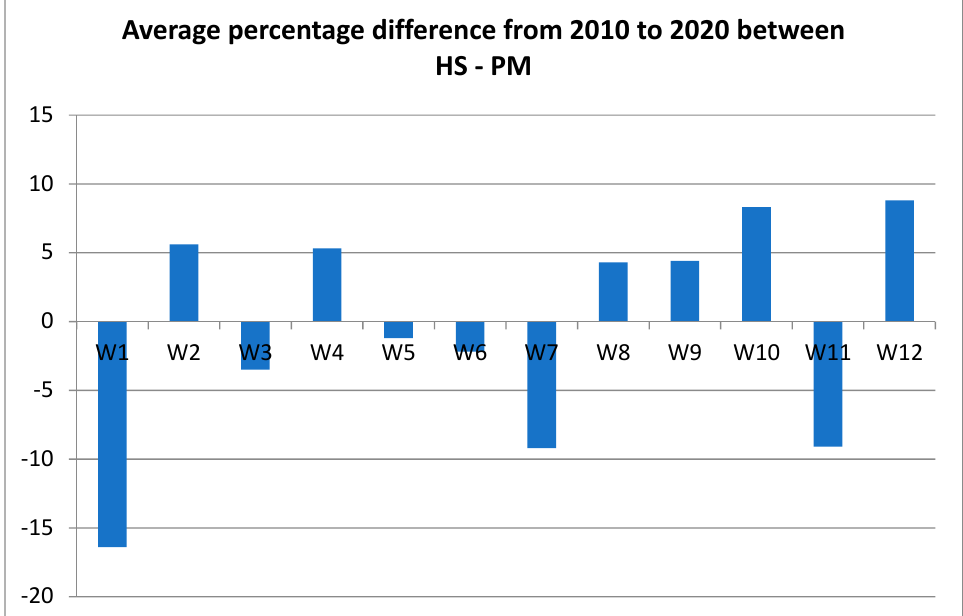
Figure 3. Average percentage difference from 2010 to 2020 between the two methods of calculation (HS-PM) of ET0 for each weather station (dif. 2010–2020). Table 5. Average percentage difference from 2010 to 2020 between the two methods of calculation (HS-PM) of ET0 for each weather station (dif. 2010–2020); 95% confidence interval between years for each weather station (95% conf. int.).